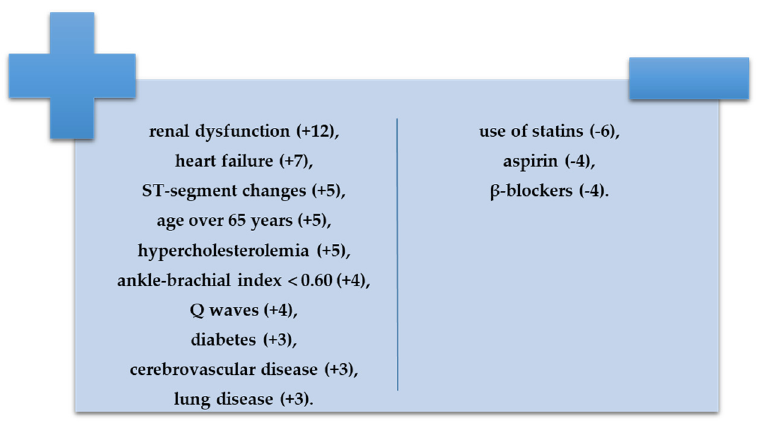
Figure 1. Risk index for 10 ‐ year mortality rate in PAD (adapted after